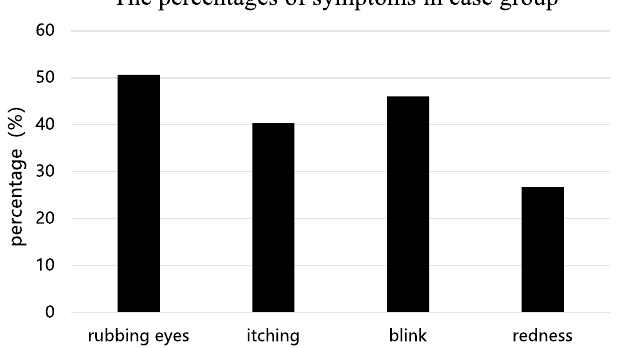
Figure 1. The percentages of symptoms in case group. 50.6% of AC patients had rubbing eyes (n = 89); 40.3% had itching (n = 71); 46.0% had blinking (n = 81). 26.7% had redness (n = 47).